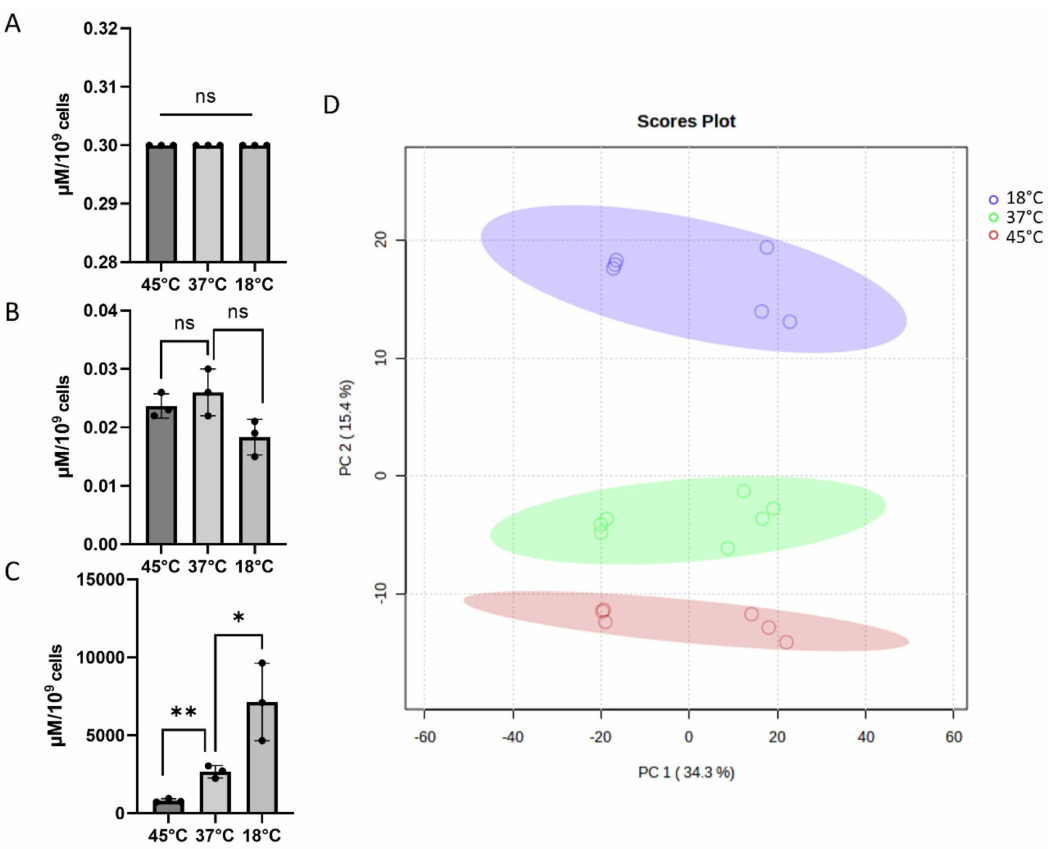
Figure 5. Trehalose ( A ), T6P ( B ), S6P ( C ) quantification of Acinetobacter baumannii AB5075 grown at 45, 37, and 18 ◦ C, respectively. PCA scores plot shows variances in metabolites (994 unassigned molecules) extracted from A. baumannii grown at the three indicated temperatures ( D ). The results correspond to n = 3 biologically independent samples for A, B, and C. The analysis was performed using MetaboAnalyst V5.0 (https://www.metaboanalyst.ca/, accessed on 2 March 2023). Statistical significances were determined by a two-tailed student’s t test **, p ≤ 0.005; *, p ≤ 0.05; ns;